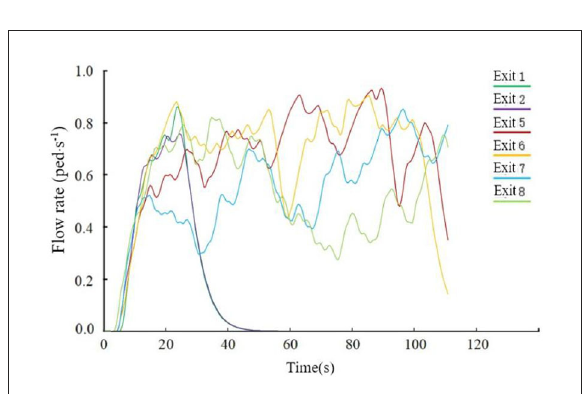
FIGURE24 Each outlet flow after